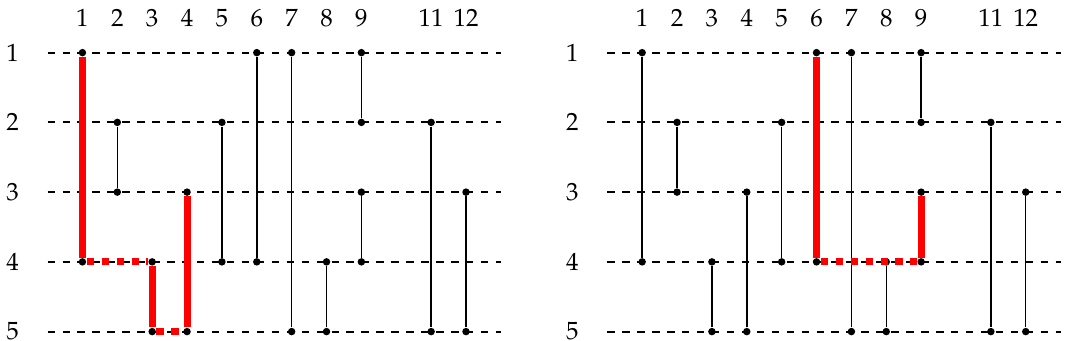
Figure 3. The earliest arrival path from node 1 to node 3 in the temporal graph of Figure 2 in the time interval [ 1,12 ] ( left ) and in the time interval [ 2,12 ] ( right ).